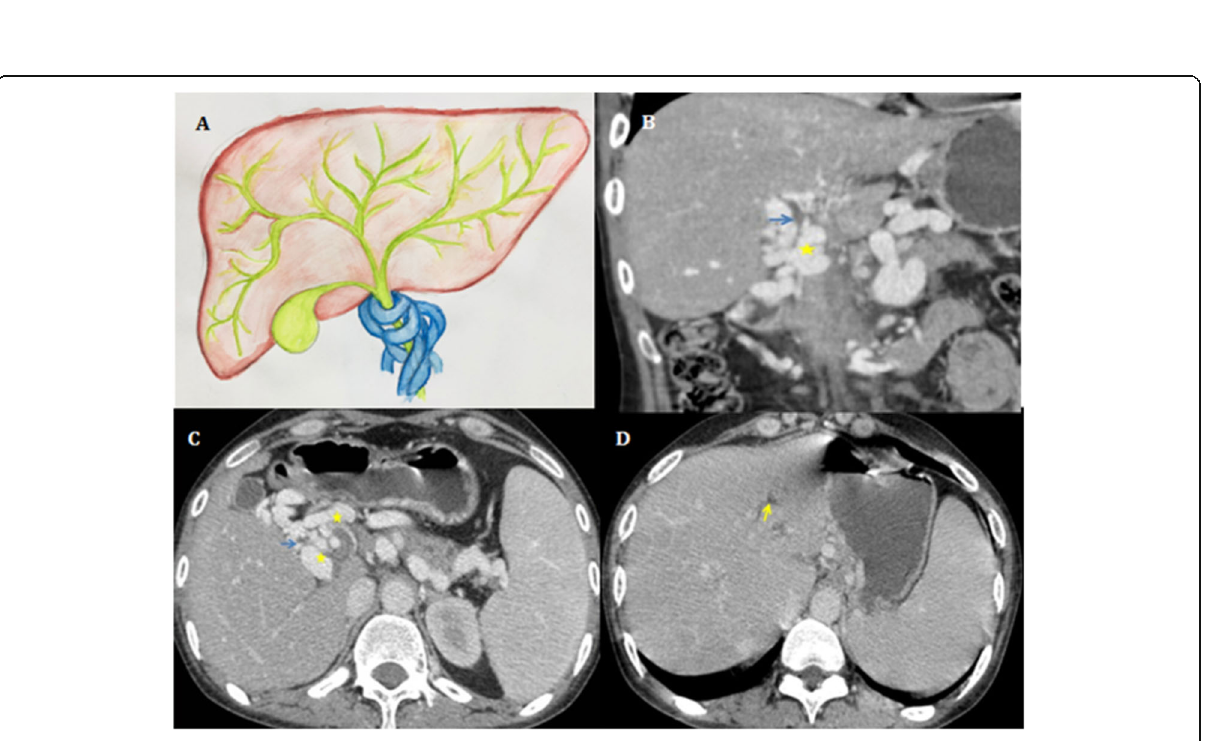
Fig. 5 A 51-year-old case with portal biliopathy. ( a ) shows hand diagram in coronal view illustrating the dilated intrahepatic biliary radicles secondary to compression of the common bile duct by the dilated and serpigenous portal cavernoma. Coronal and axial views ( b and c ) contrast-enhanced CT study of the abdomen in venous phase shows cavernous transformation of the portal vein (asterisk) at the porta hepatis causing compression with proximal dilatation of the common bile duct (arrow). ( d ) shows dilated intrahepatic biliary radicle involving the left lobe of the liver (arrow). The hand diagram is self-drawn by the